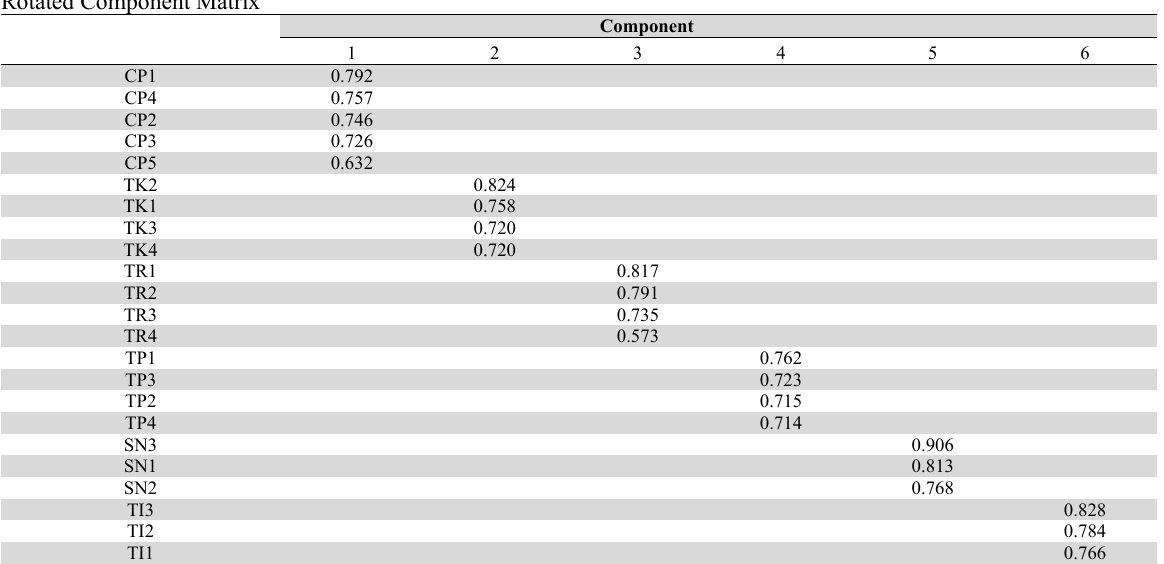
Rotated Component Matrix